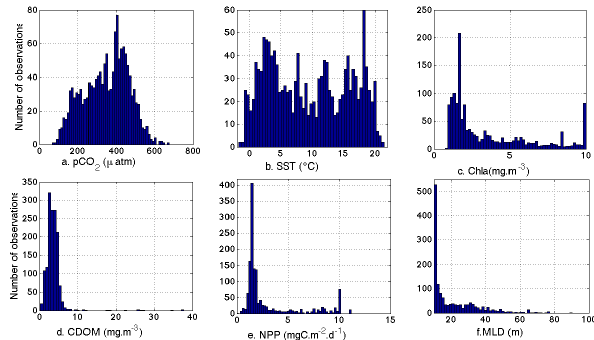
Figure 8. Histogram of (a) p CO 2 and satellite data, (b) SST, (c) Chl a , (d) NPP, (e) CDOM, and (f) MLD available for the SOM after reconstruction. Y axis represents the number of data, and the x axis the value of the